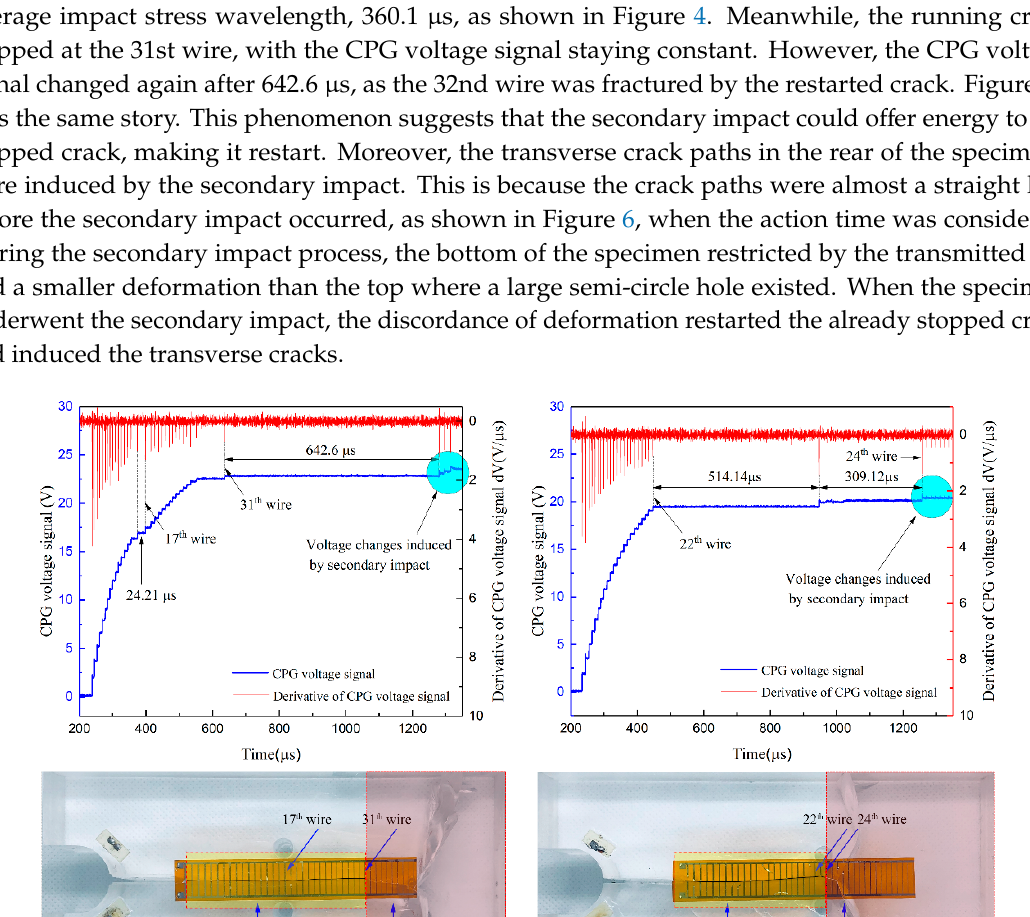
Figure 6. The voltage signal curves of crack propagation gauges (CPGs) and the crack paths of the specimens. ( a ) B20-D30 specimen. ( b ) B16-D45 specimen. specimens. ( a ) B20-D30 specimen. ( b ) B16-D45